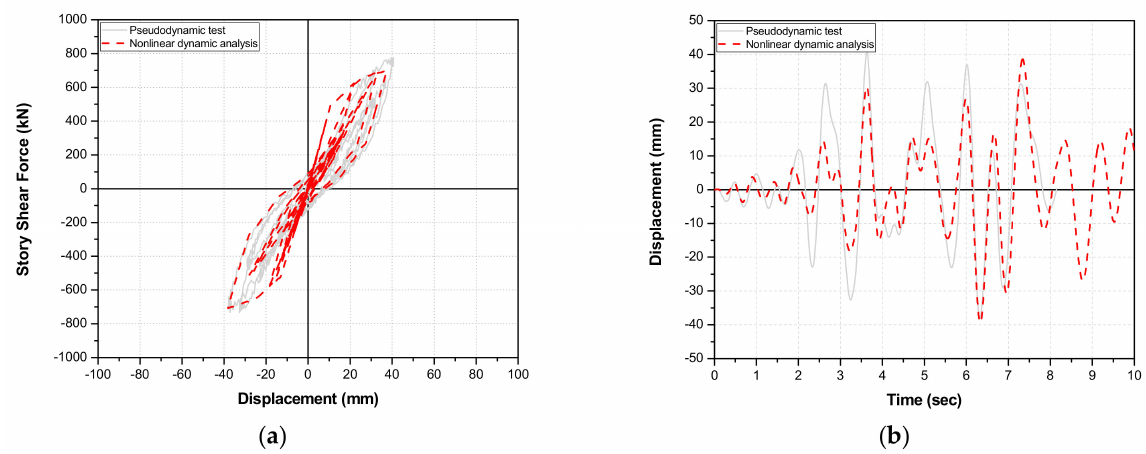
Figure 24. Comparison of non-linear dynamic analysis and pseudo-dynamic test results of the test frame retrofitted with the CFT-MF system (PD-CFT-MF) (first floor, 400 cm/s 2 ): ( a ) load-displacement curves; ( b ) displacement-time hysteresis